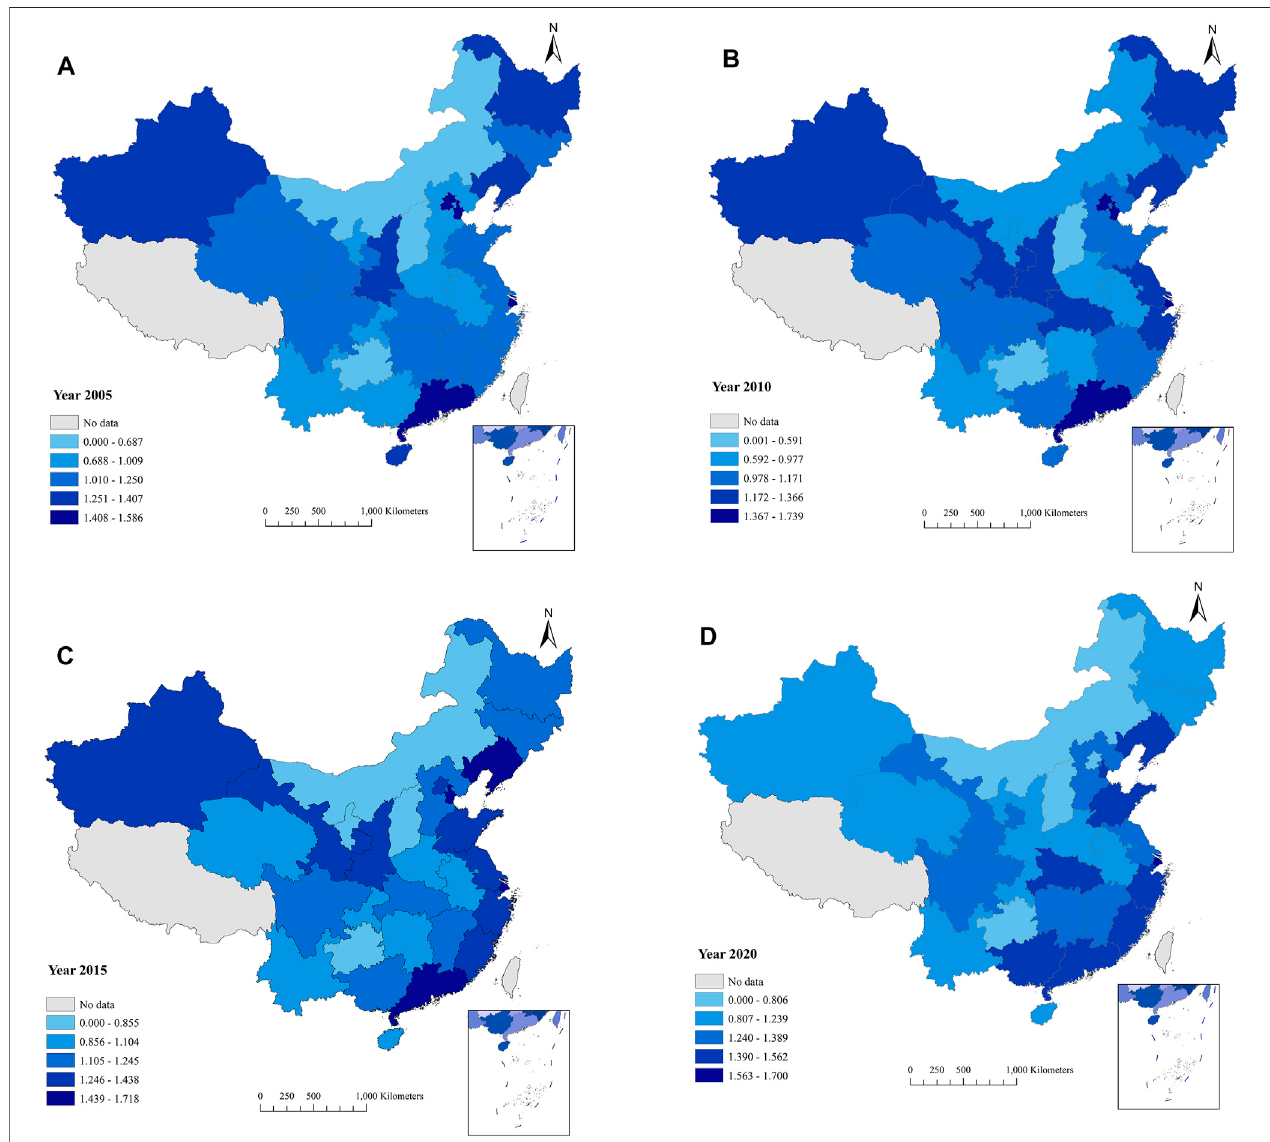
FIGURE 1 | Spatial and temporal variation of the information entropy of the carbon emission structure in China for main years from 2005 to 2020. (A) 2005, (B) 2010, (C) 2015, and (D) 2020.